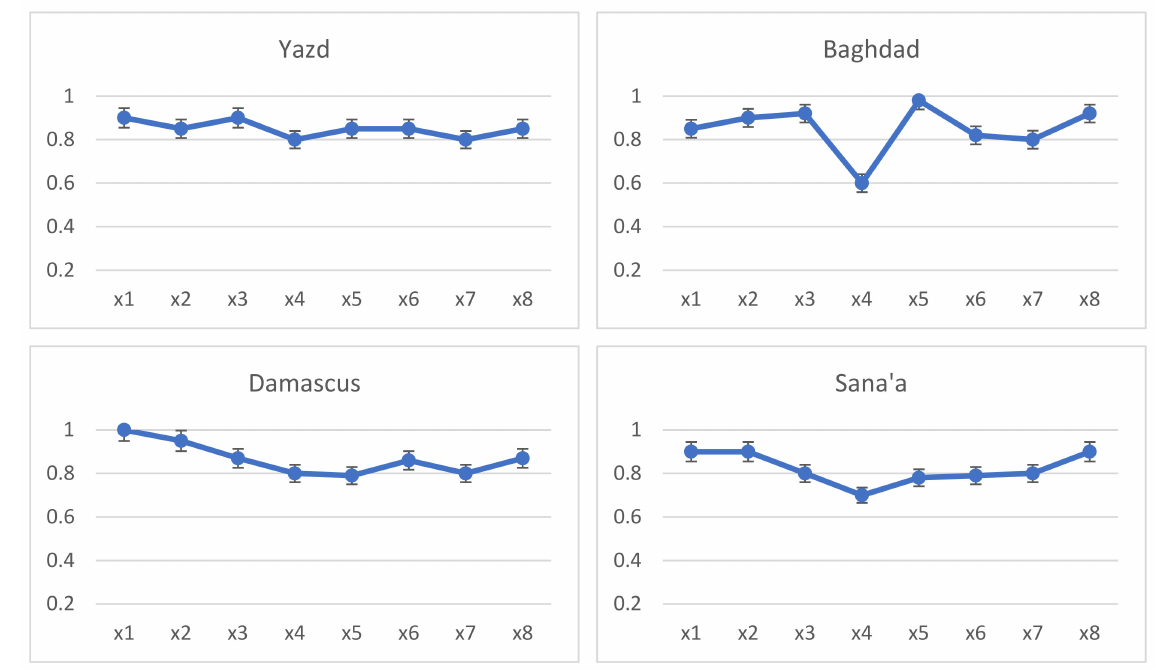
Figure 12. Indictors’ values for the four case study cities.